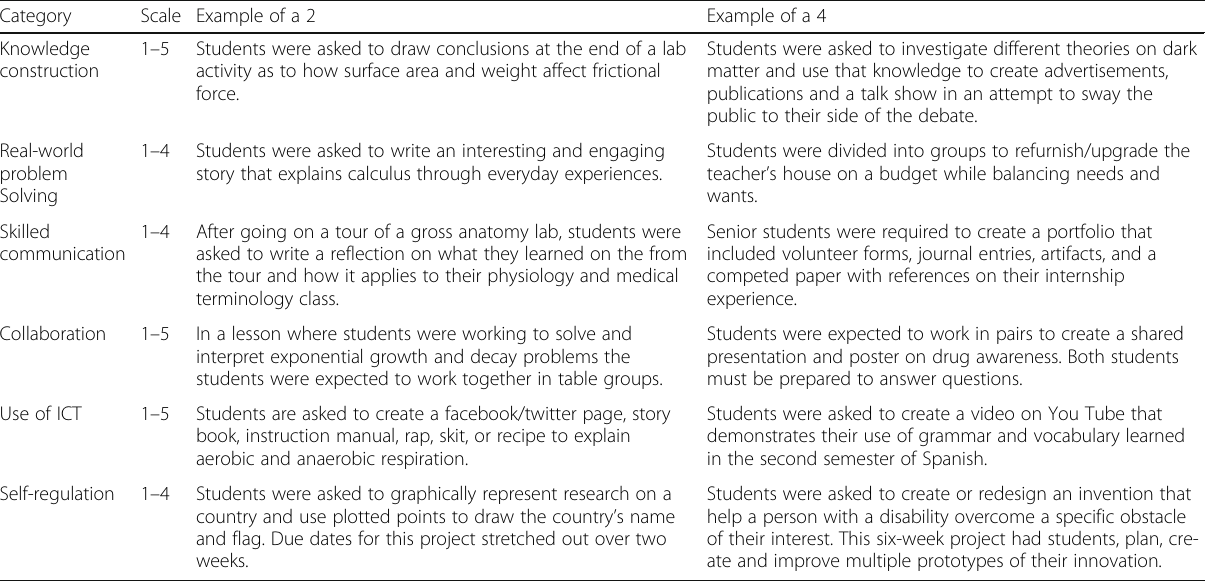
Table 4 Examples of teacher lesson plans as assessed with the 21CLD learning activity